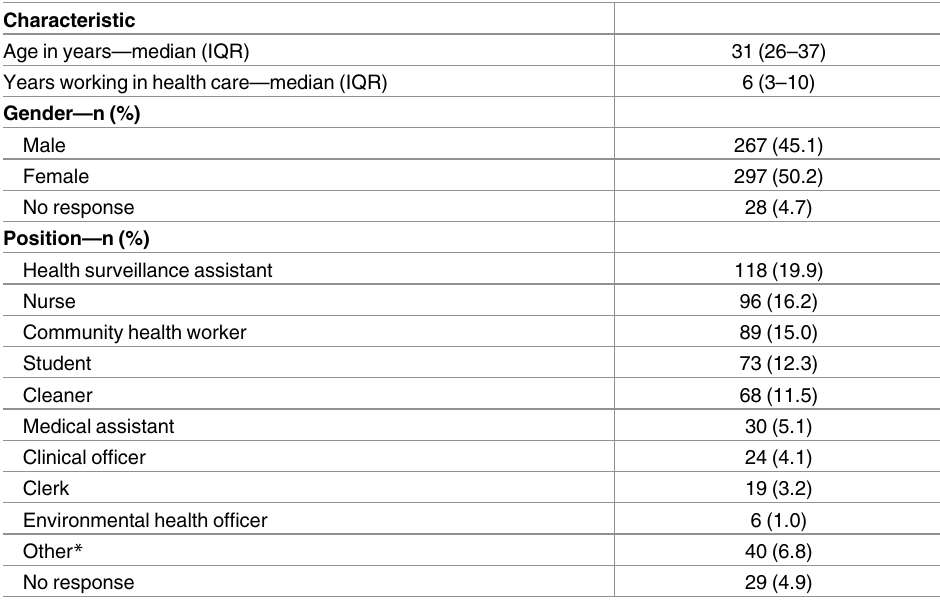
Table 2. Characteristics of HCW respondents (N =